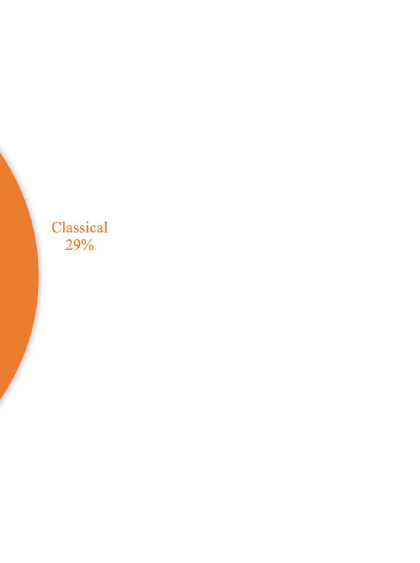
Figure 2. Choice of music within MIG, n =